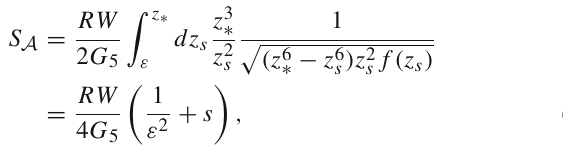
√ ρ = 1 . 0, and black one is for